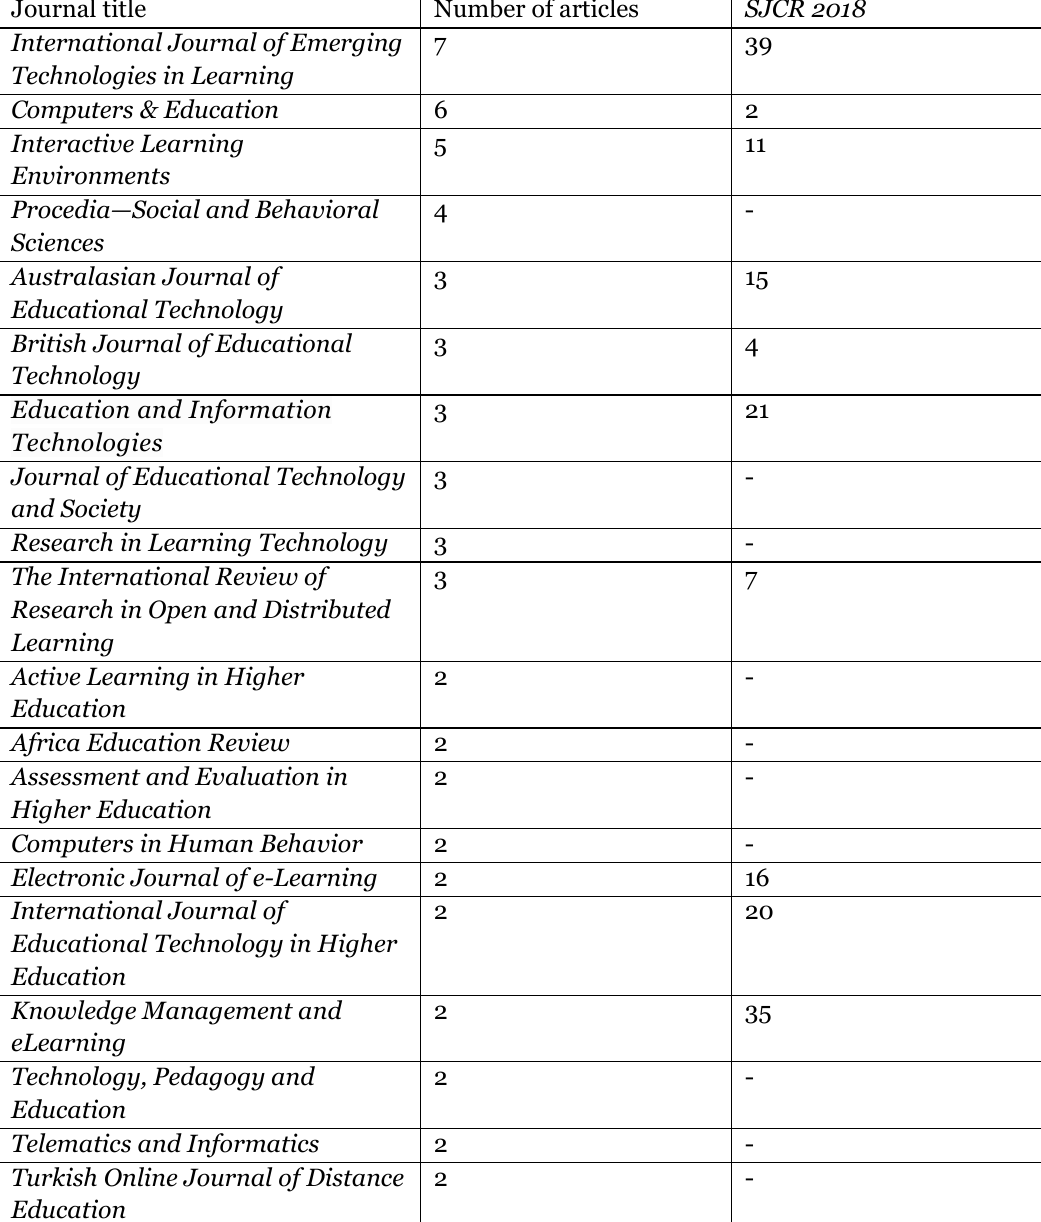
Journals in the Sample Featuring Two or More Relevant Articles, and the Journals’ Scimago Journal